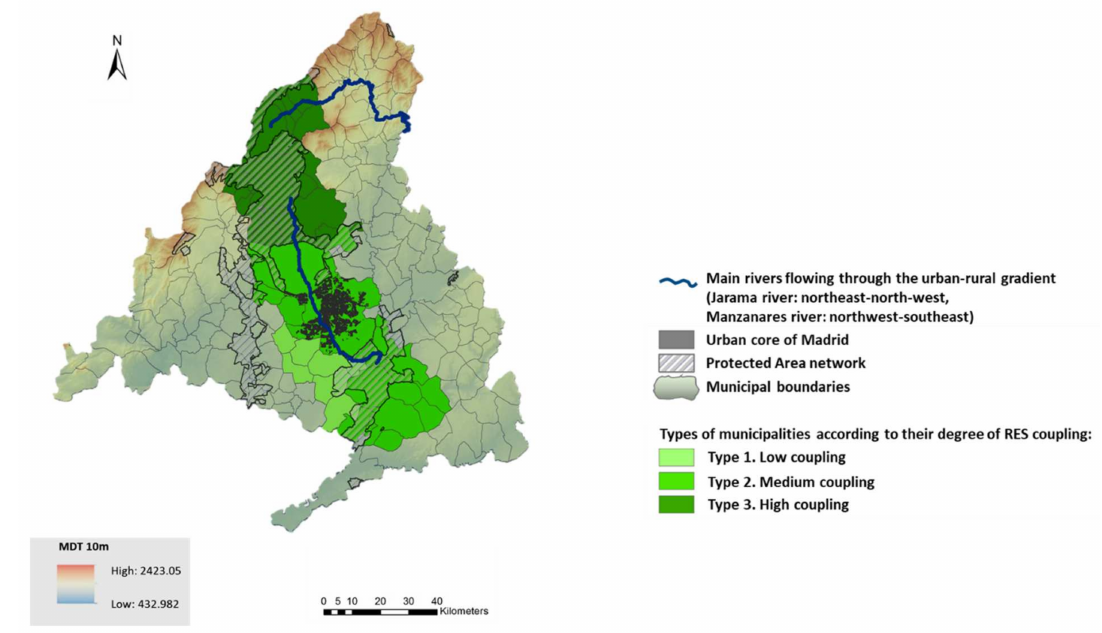
Figure 5. Mapping of recreational ecosystem services. Spatial projection of the types of municipalities along the rural-urban gradient studied according to their degree of coupling between the supply and demand for